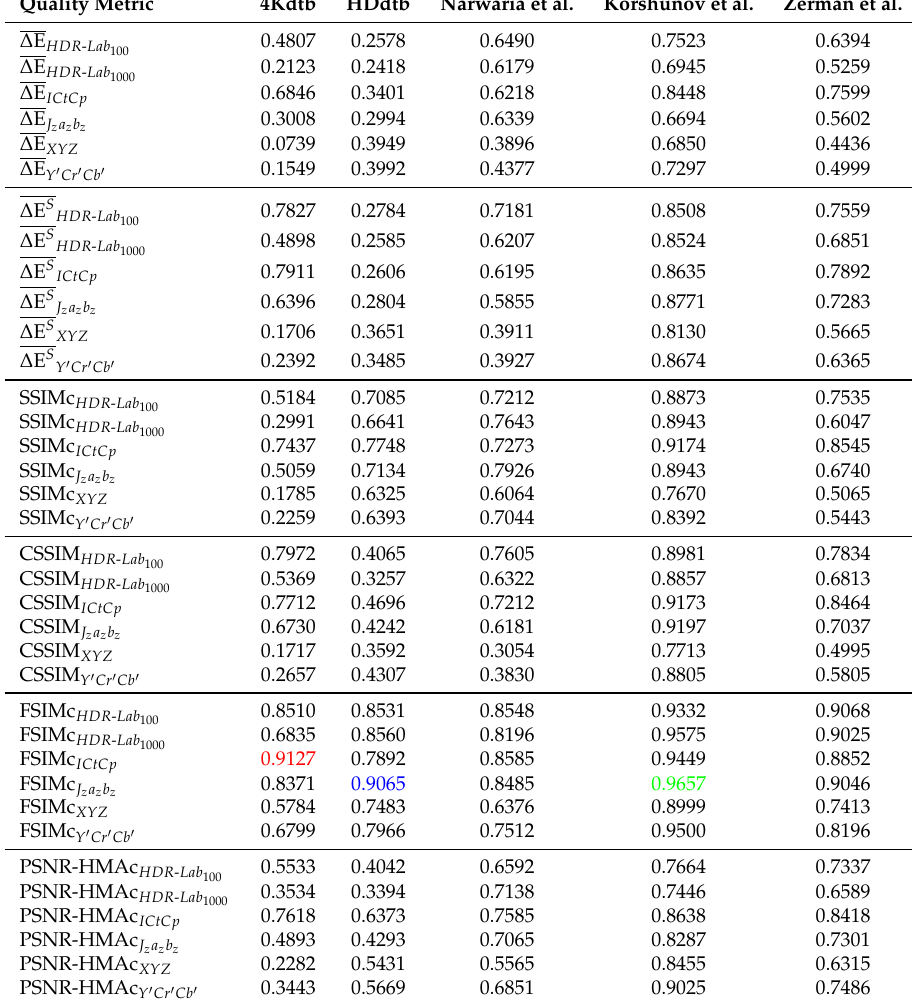
Table A4. SROCC of the different color quality metrics on the considered